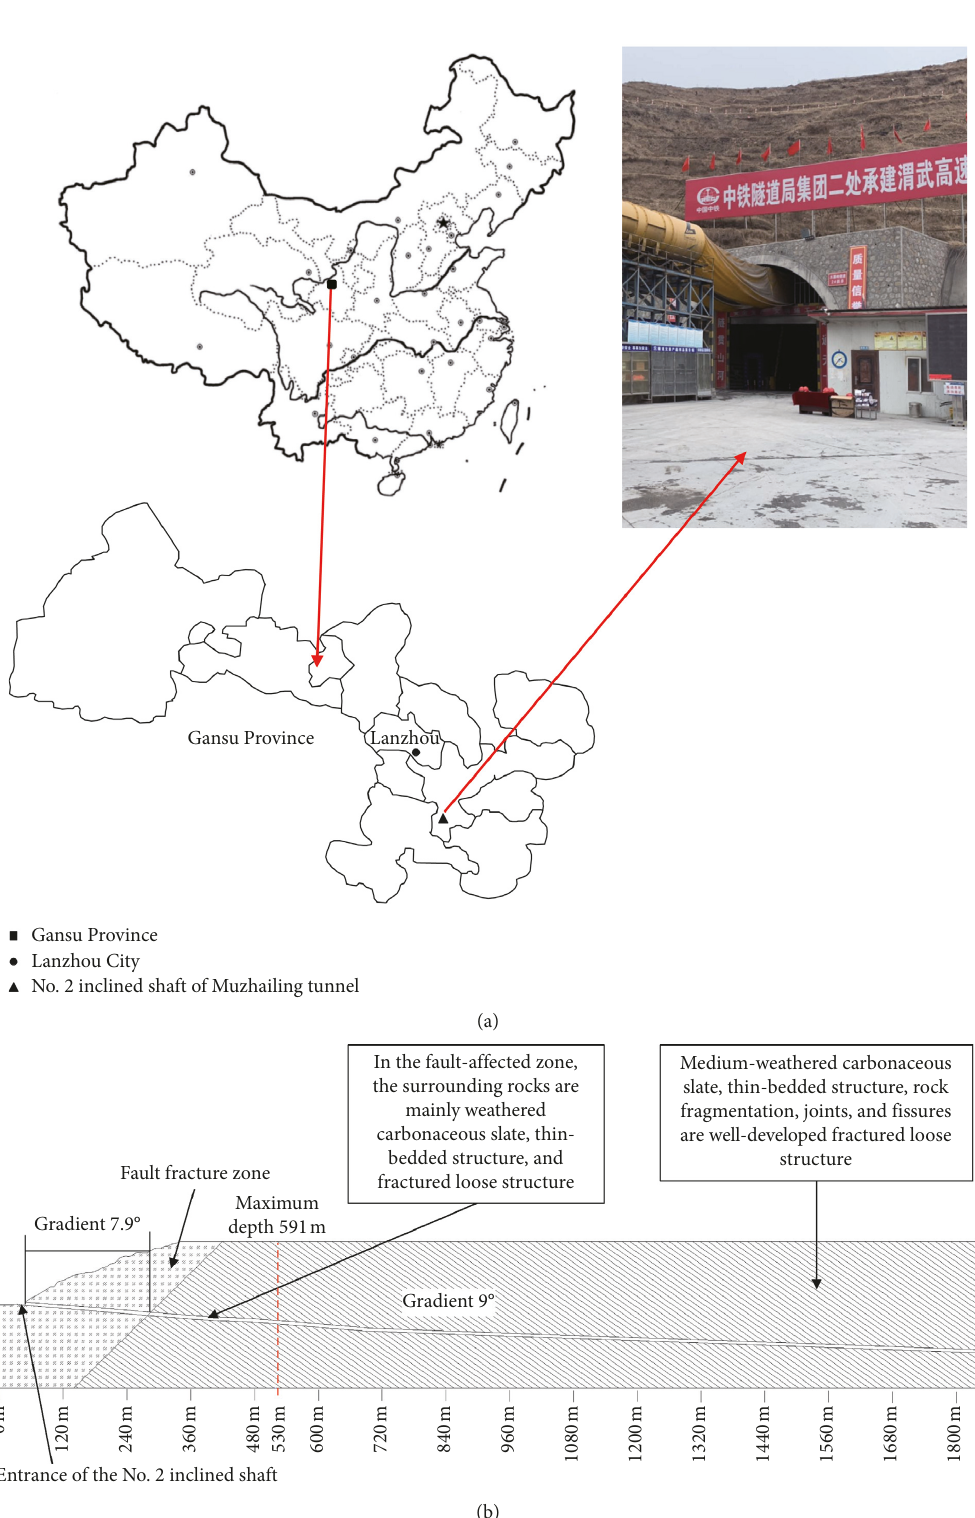
Figure 1: The overview situation of the no. 2 inclined shaft. (a) The geographical location of the no. 2 inclined shaft of the Muzhailing tunnel. (b) The longitudinal section of the no. 2 inclined